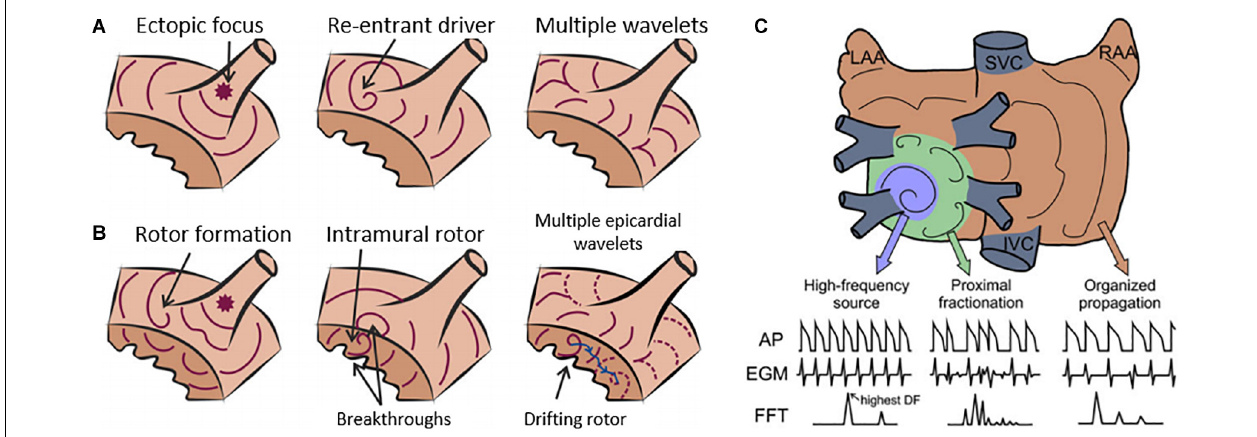
FIGURE 2 | Current hypotheses for atrial fibrillation (AF) maintenance. (A) Diagram of AF maintenance near a pulmonary vein driven by ectopic focus (left), re-entrant driver (middle), or multiple wavelets (right). (B) Re-entrant drivers, or rotors, can be initiated by wave breaks near an ectopic focus (left) and underlie endocardial or epicardial breakthroughs (middle). A drifting rotor (right) can be the driver of multiple and apparently disorganized atrial wavelets. (C) Re-entrant drivers in general, present some spatiotemporal periodicity, and thus electrograms (EGMs) are regular. Spectral analysis identifies a dominant peak that matches the activation frequency of the re-entrant driver, which is the fastest across the atria. At the periphery of the re-entrant driver, propagation is disrupted as some activations are blocked. The variations in activation times and directions at the boundaries of the re-entrant driver result in EGMs with variable morphology and fractionation, with multiple peaks in the power spectrum. At more distal sites, the activation rate is reduced leading to fewer wave breaks and a more regular activity. Modified from Guillem et al.